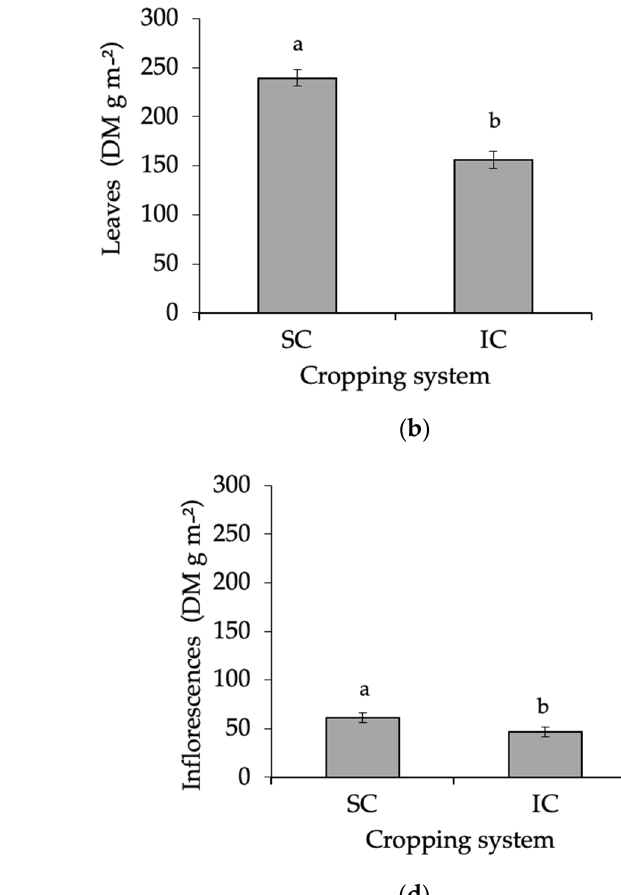
for p ≤ 0.05. * Values are means of two years, five N rates, two harvesting stages, and three replicates. ** Values are means of two years, two cropping systems, two harvesting stages, and three replicates.